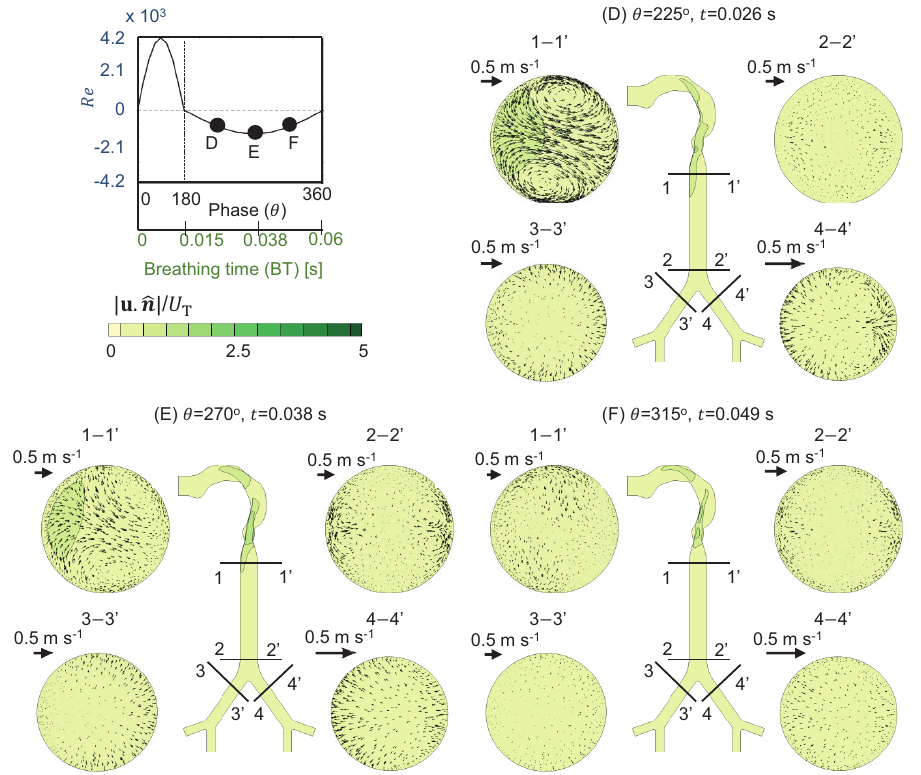
Figure 6. Contours of magnitude of plane-normal velocity component (non-dimensionalized with mean flow speed in trachea, U T ) with superimposed in-plane velocity vectors for Planes 1–4 at various time-points during exhalation for Wo = 24.1 at IT/BT = 25%. D is at Phase θ = 225 ◦ (=25% ET), E is at Phase θ = 270 ◦ (=50% ET) and F is at Phase θ = 315 ◦ (=75%